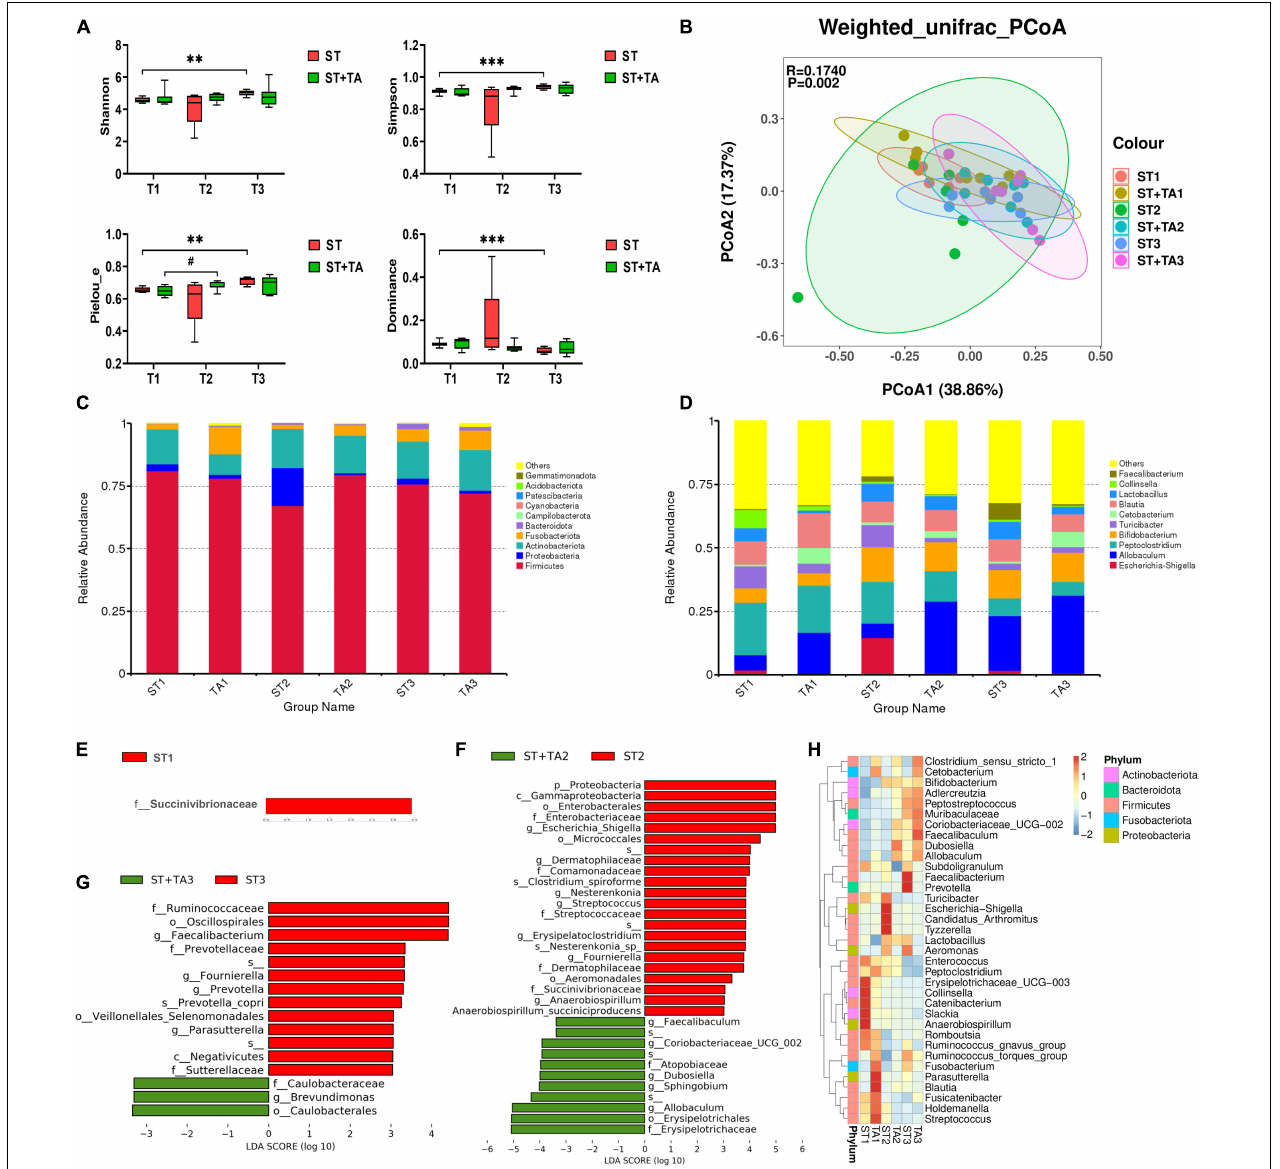
FIGURE 4 | Effect of TA on gut microbiota composition and structure in dogs. α -diversity analysis (Shannon, Simpson, Pielou_e, and Dominance) (A) , principal coordinate analysis (PCoA) based on weighted UniFrac distances (B) , histogram of abundance distribution at the phylum level (C) and genus level (D) , the LEfSe analysis among groups (E–G) , and hierarchical clustering (H) . Data are presented as mean ± SE ( n = 6 or 7). ∗∗ p < 0.01 and ∗∗∗ p < 0.001 represent the difference of each group at T1–T3 calculated by RM-ANOVA. # p < 0.10 represents the difference in tendency of each group at T1–T3 calculated by RM-ANOVA. The p -values of β -diversity index in the PCoA calculated by the Wilcoxon rank sum test. T1, day 7 before transportation; T2, day 8 after transportation; T3, day 14 after